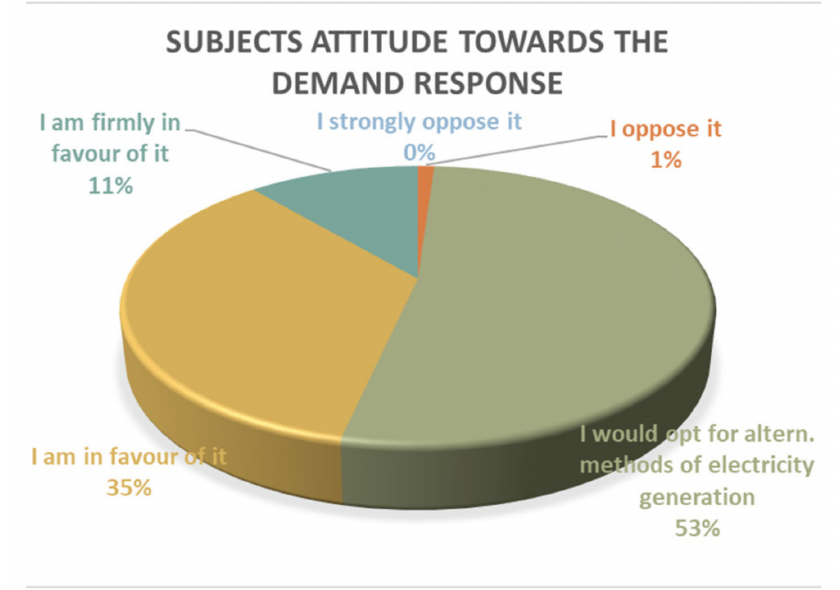
Figure 3. Consumers attitude toward the demand response. Source: Authors’ own